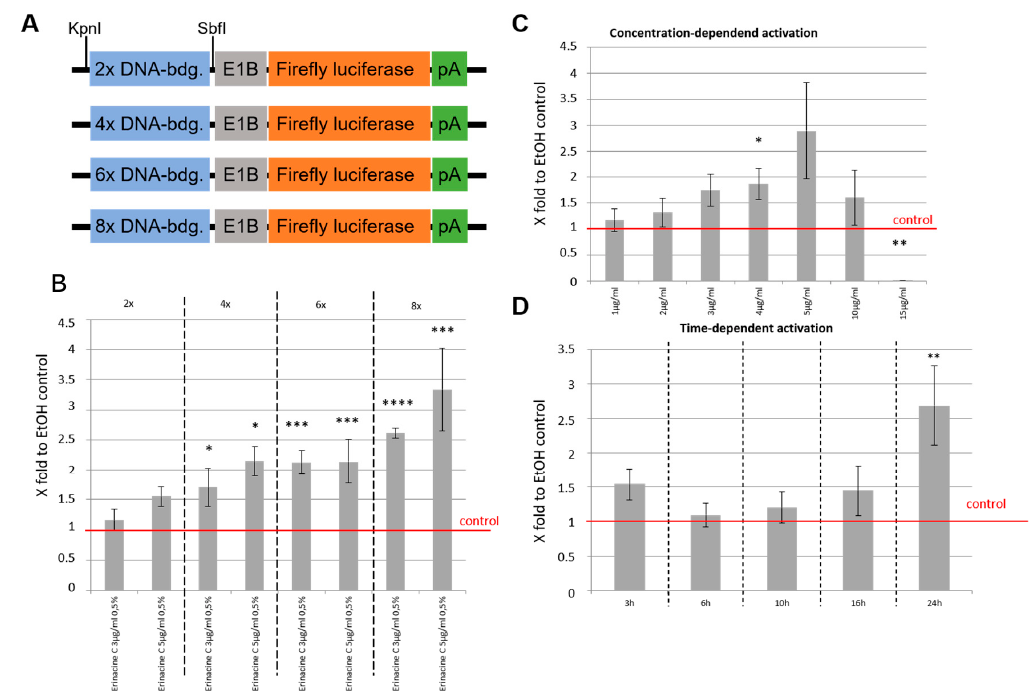
Figure 5. Erinacine C activates ETS-reporter construct in a concentration dependent manner. ( A ) Series of constructed reporter plasmids containing 2, 4, 6, or 8 ETS1 binding sites followed by the E1b minimal promoter and Firefly luciferase. ( B ) Transfection of these constructs into 1321N1 cells followed by incubation with either 3 or 5 µ g / mL of erinacine C for 24 h. Fold-upregulation of luciferase activity in dependence of the di ff erent erinacine C concentrations and increasing numbers of ETS binding sites are displayed. ( C ) Fold-upregulation of luciferase activity with the 8 x ETS reporter construct upon increasing erinacine C concentrations up to 5 µ g / mL. Higher erinacine C concentrations yielded lower luciferase activity values probably due to altered expression responses in 1321N1 cells. ( D ) Fold-upregulation of luciferase activity with the 8 x ETS reporter construct and 5 µ g / mL erinacine C incubation in dependence of varying incubation times. EtOH treated cells served as controls for which luciferase activity was set as one in all displayed assays (red line) (four values per treatment, four independent cultures). * p < 0.05, ** p < 0.01, *** p < 0.001, **** p <